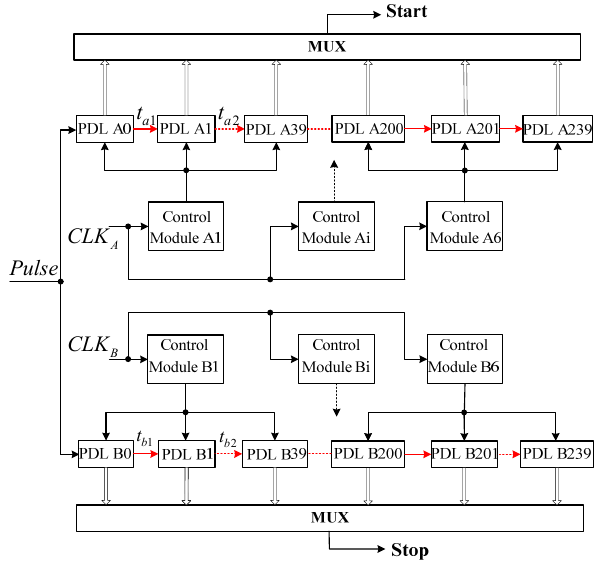
Figure 4. A simplified block diagram of the proposed DTC.